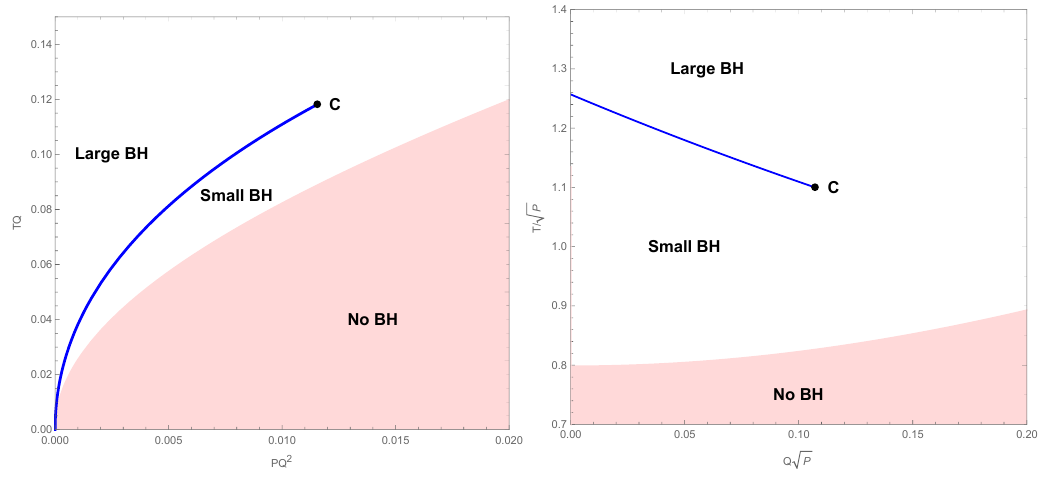
Figure 8 . Phase diagrams of a RN-AdS black hole in a cavity in the PQ 2 - TQ ( Left Panel ) and p p Q P - T= P ( Right Panel ) planes. The (cid:12)rst-order phase transition lines separating Large BH and Small BH are displayed by blue lines and terminate at the critical point, marked by black dots. The coexistence lines are of (cid:12)nite length and reminiscent of the liquid/gas phase transition. No BH regions correspond to T < T min , and hence no black hole solutions exist in light red regions.